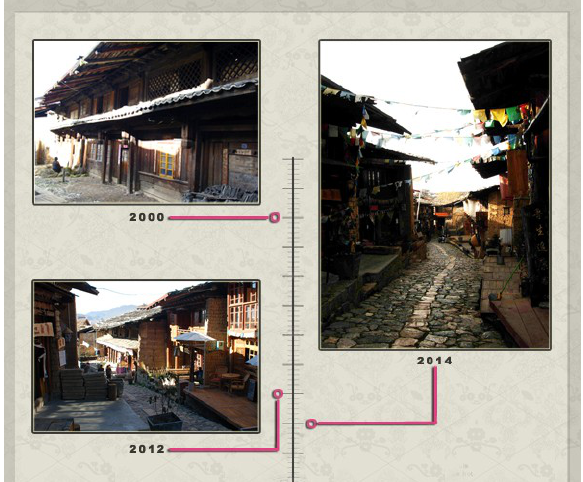
Figure 7. Collected Photo of Court Shop before the